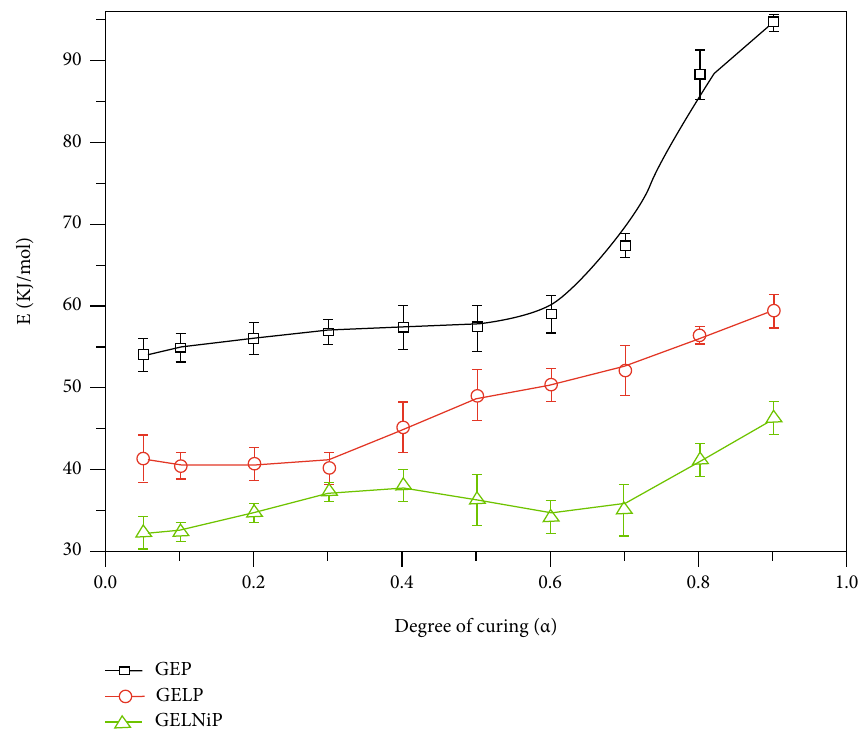
Figure 5: Variation of E α versus conversion for GEP, GELP, and GELNiP nanocomposites derived from Friedman